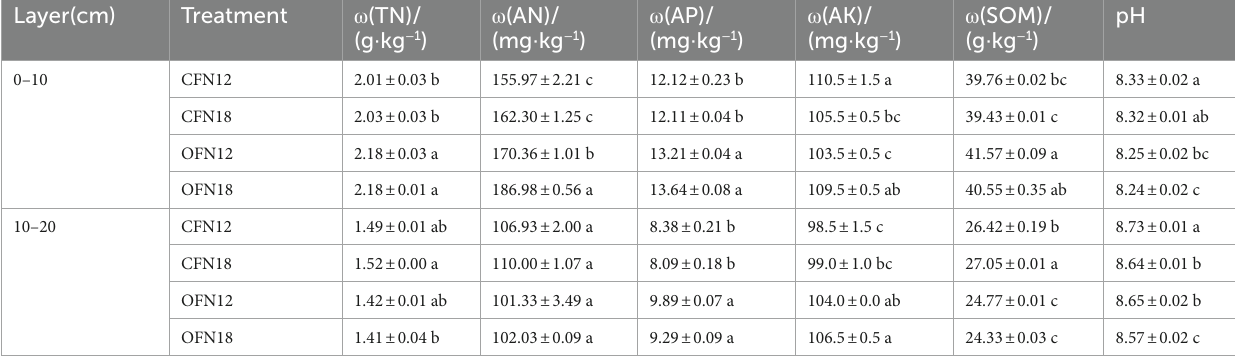
TABLE 2 Effects of two nitrogen levels under organic and conventional cultivation on soil nutrients.